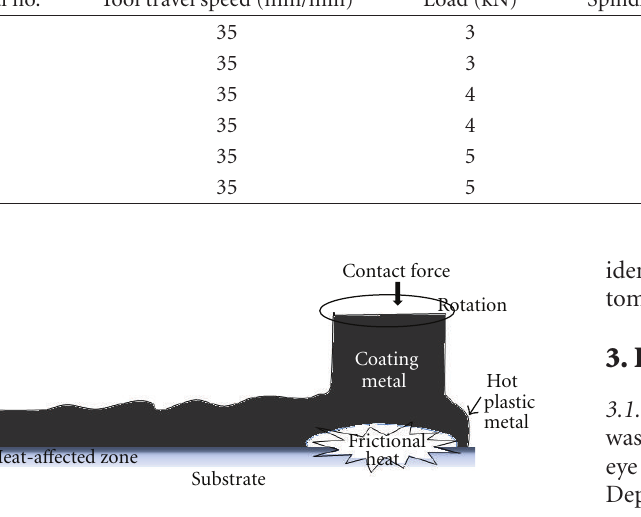
Figure 1: Scheme of friction surfacing